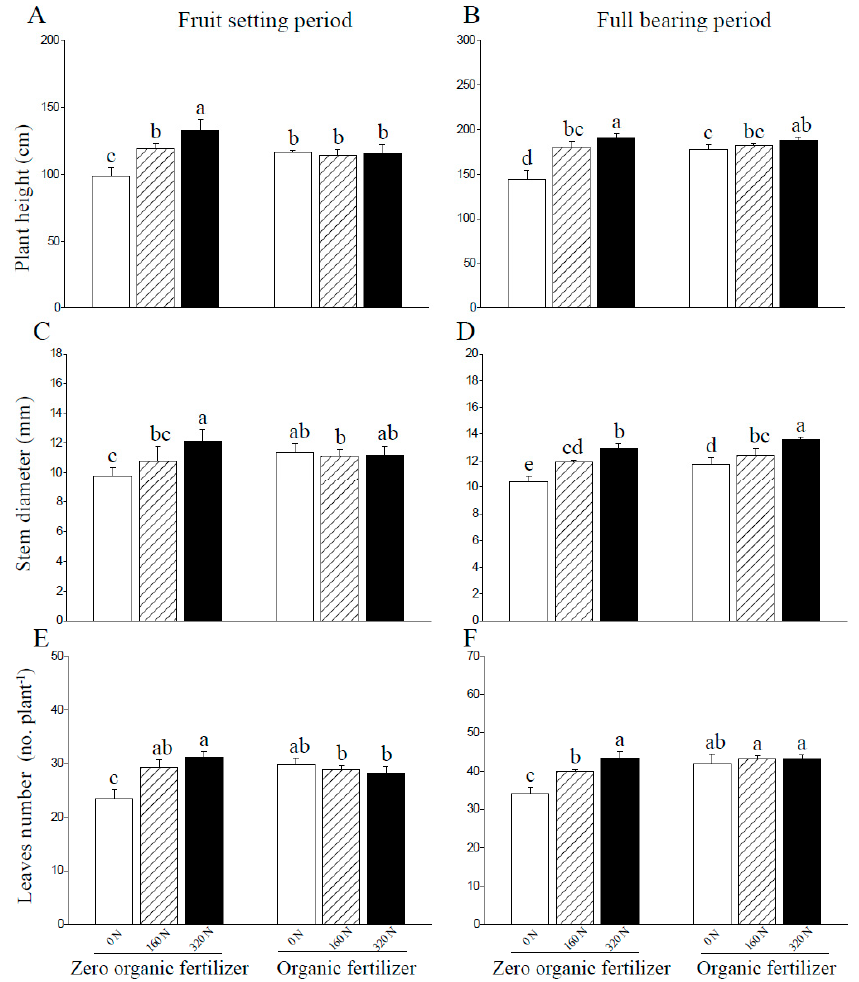
Figure 2. The comparisons of plant height ( A , B ), stem diameter ( C , D ) and leaves number ( E , F ) of cherry tomato between the three N rates (0, 160 and 320 kg N ha − 1 ) and two different chicken manure rates (0 and 40 t N ha − 1 ) during the 2021–2022 growth season. Vertical bars above mean values indicate standard error. Means with different lower-case letters show significant differences between six combination treatments among the three N application rates under and the two chicken manure doses according to the least significant difference method (LSD 0.05 ).